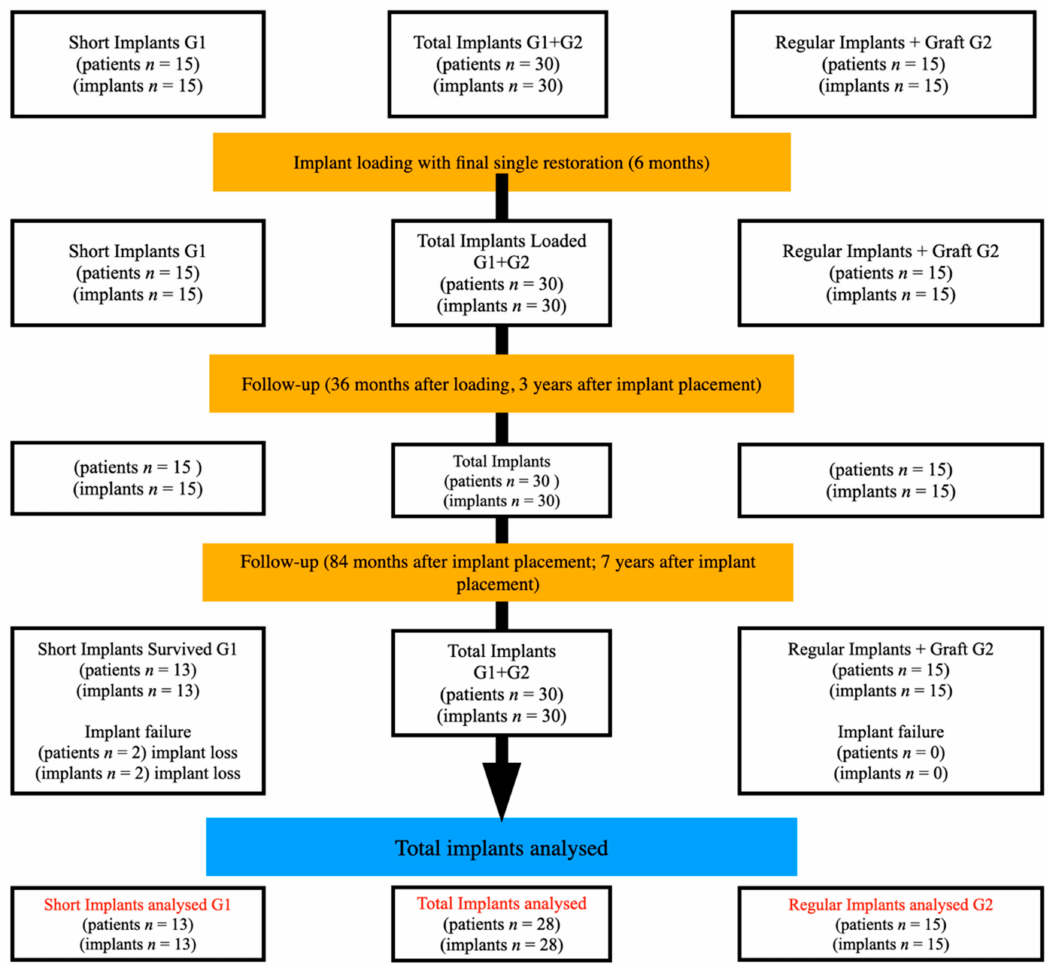
Figure 1. Flow chart of study schedule and